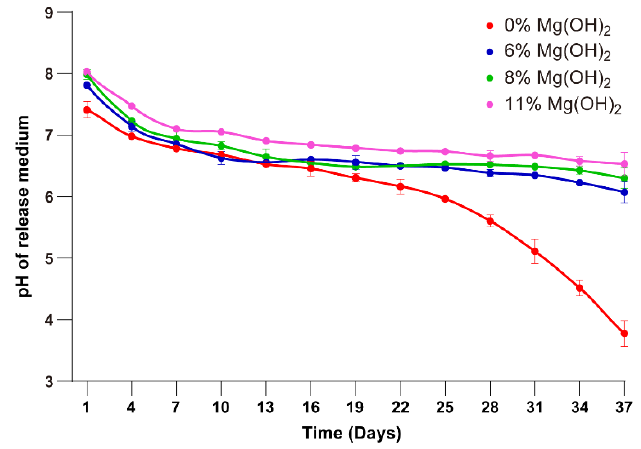
Figure 5. pH curves of release medium during the incubation (means ± SD, n = 3). 1: MS 0% Mg(OH) 2 , 2: MS 6% Mg(OH) 2 , 3: MS 8% Mg(OH) 2 , 4: MS 11% Mg(OH) 2 (1 vs. 2–4, p < 0.05).